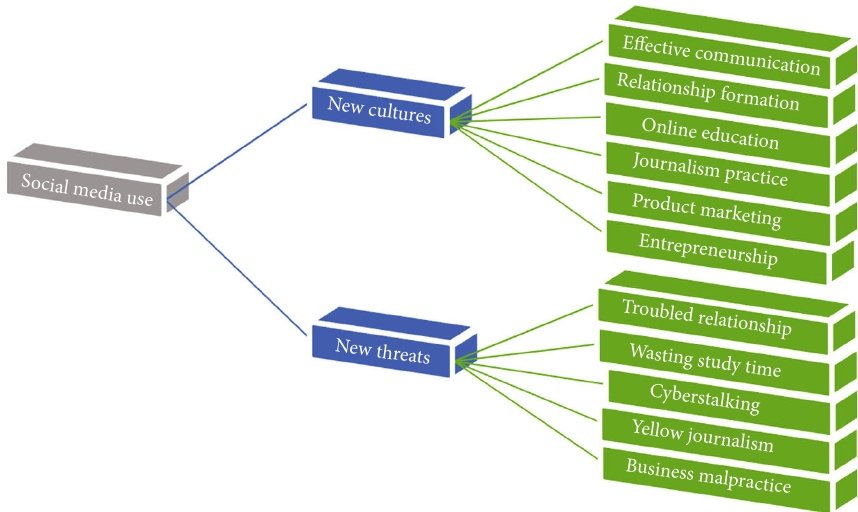
Figure 1: Conceptual